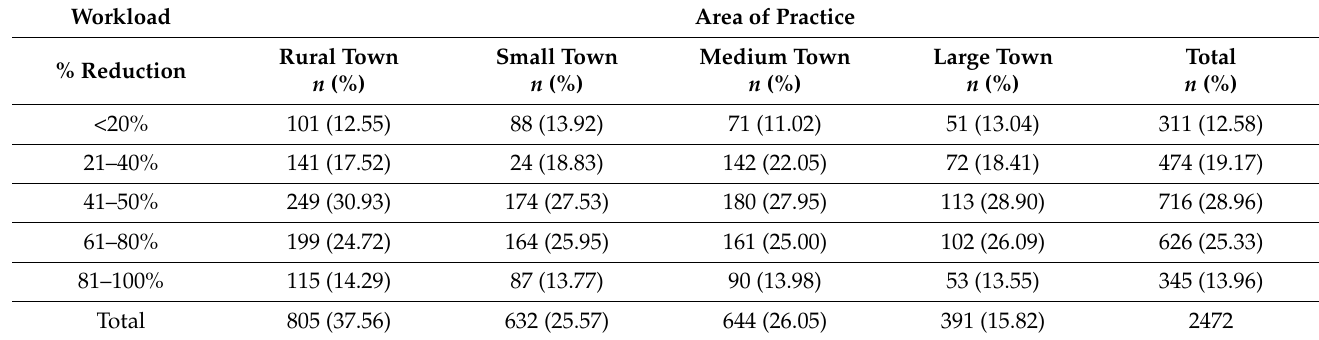
Table 3. Weekly workload reduction during the lockdown period by in the different practice areas grouped by number of inhabitants.